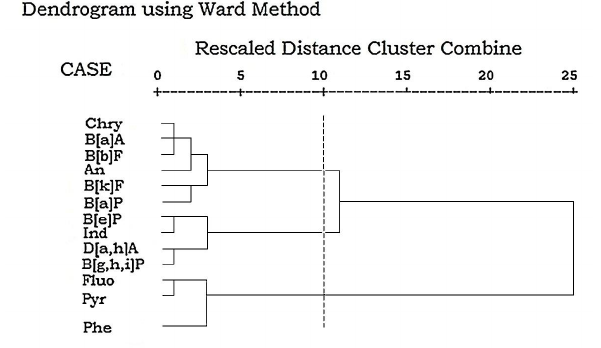
Figure 4. Hierarchical Cluster Analysis (HCA) of 13 individual PAHs in Khao Lak 2 Fig. 4. Hierarchical Cluster Analysis (HCA) of 13 individual PAHs in Khao Lak sediment. 3